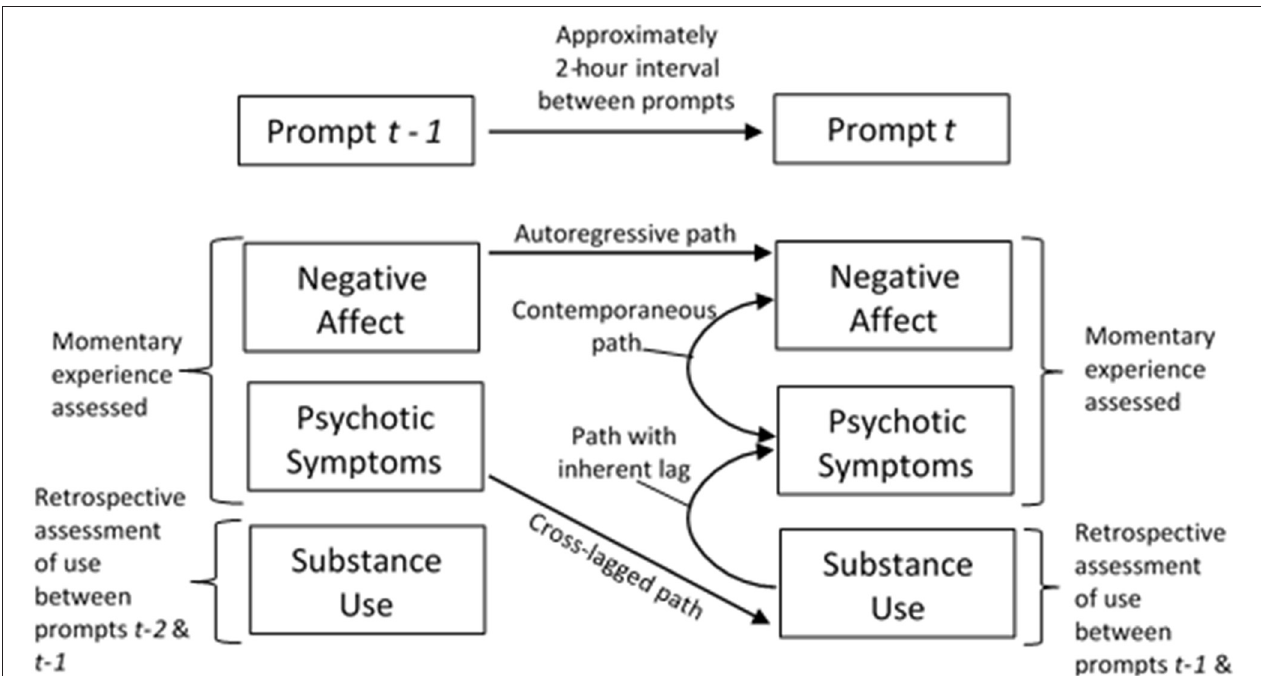
FIGURE 2 | Experience sampling methodology with multilevel vector autoregressive (MVAR) estimation of autoregressive, cross-lagged, and contemporaneous